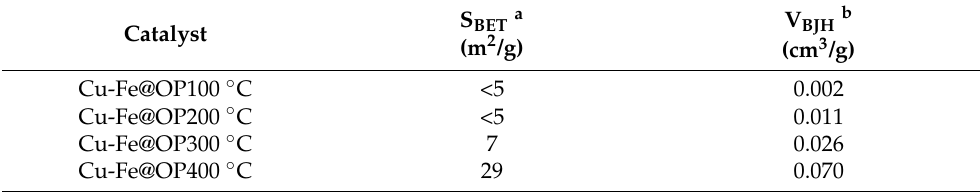
Table 1. Textural properties of Cu-Fe@OP samples.